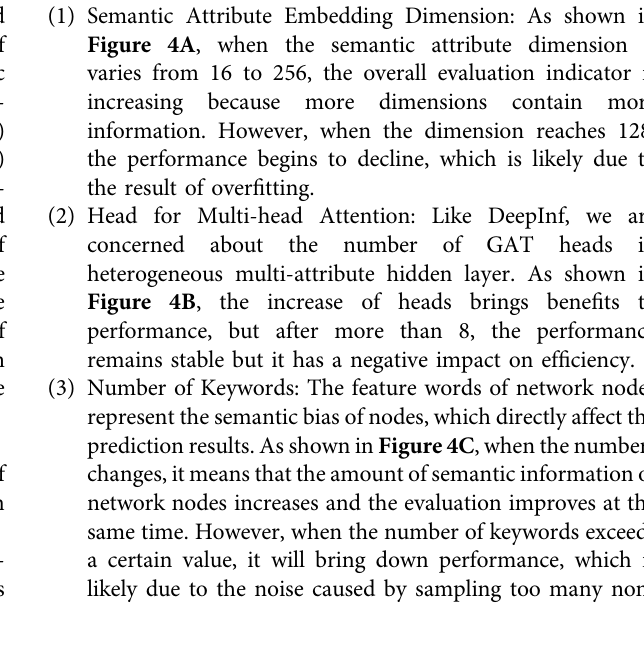
Frontiers in Physics |